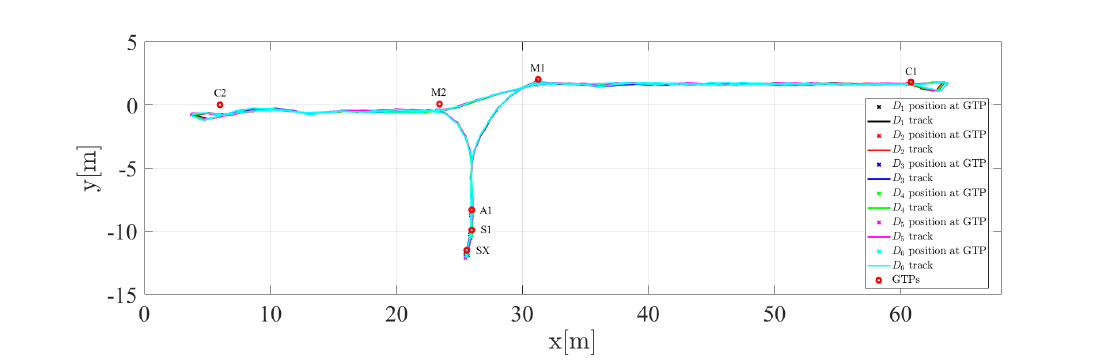
Figure 5. Resulting tracks after performing partly successive FeetSLAM for one walk with 6 sensors mounted on the foot. The window size was 3 and the number of iteration was